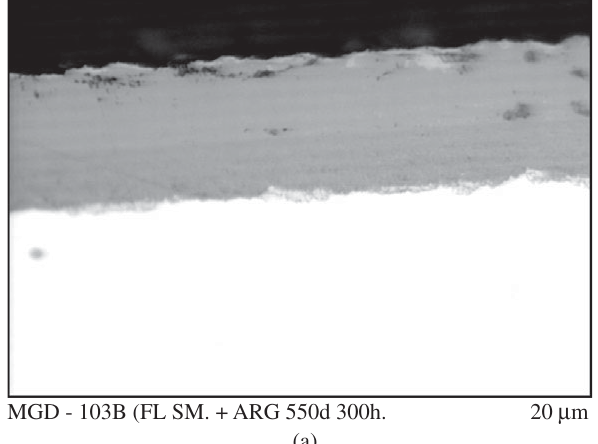
steam.MGD Figure 4. Microstructure of oxide scales grown on 9Cr1Mo(2) steel at 550 °C for 300 h using different laboratory procedures: a) ar- gon/50% H O; b) flowing steam; c) static high pressure 2